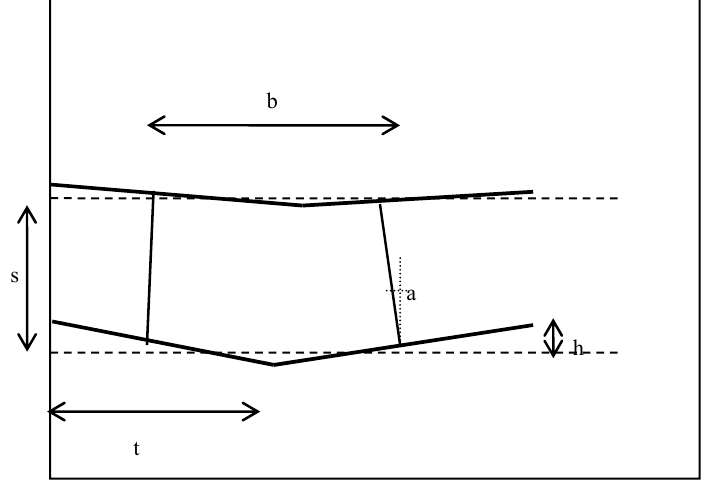
Figure 5. Definition of geometric parameters in block generation procedure.